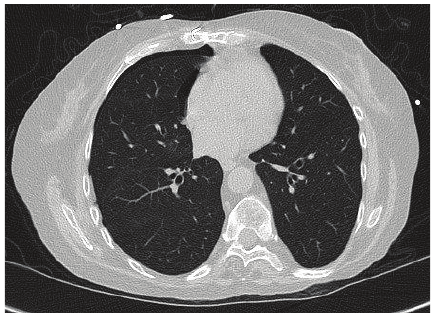
Figure 2: Computed tomography scan of the chest revealing resolution of nodule at 3